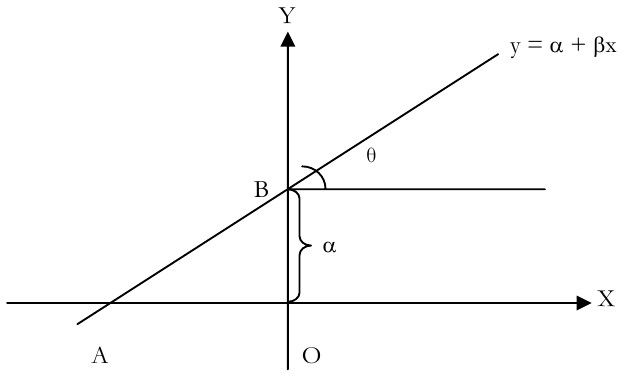
Figure 1 – Regression of y on x